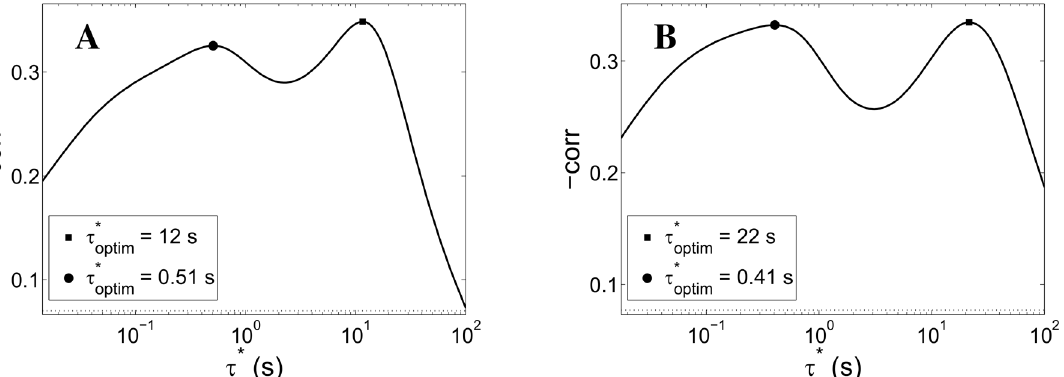
Fig 9. Slow time-scales inference procedure on simulation data with STD and spike-frequency adaptation. Correlation between low-pass filtered network activity f (see Eq 19) and the size of the immediately subsequent network spike plotted against the time-scale τ * of the low-pass integrator. In this case, the mean-field model includes, besides short-term depression (STD), a mechanism mimicking spike-frequency adaptation. Panel A: spike-frequency adaptation with characteristic time τ SFA = 15 s. Panel B: τ SFA = 30 s. In both cases the correlation presents a STD-related peak at around τ * ’ 500 ms ( τ STD = 800 ms), consistently with Fig 7. The peaks at higher τ * s, found respectively at 12 and 22 s, in accordance with what is reported in the plot legends and in the main text, roughly preserve the ratio of the corresponding τ SFA